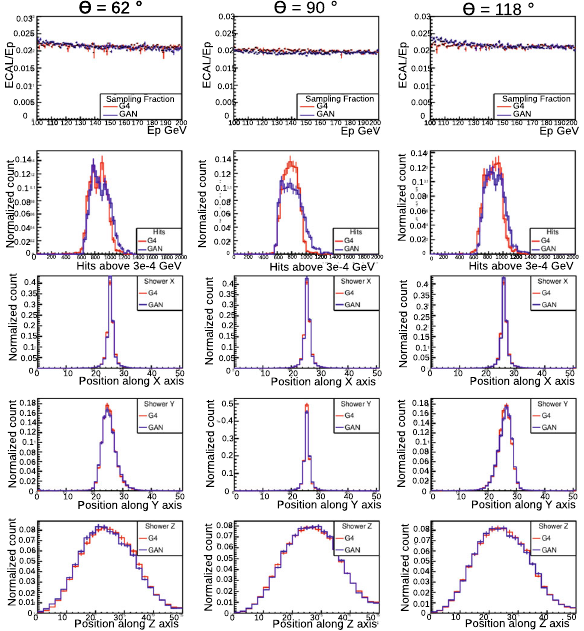
Fig. 9 GEANT4 vs. GAN comparison for sampling fraction, number of hits and shower shapes along x, y, z axis for different angle bins